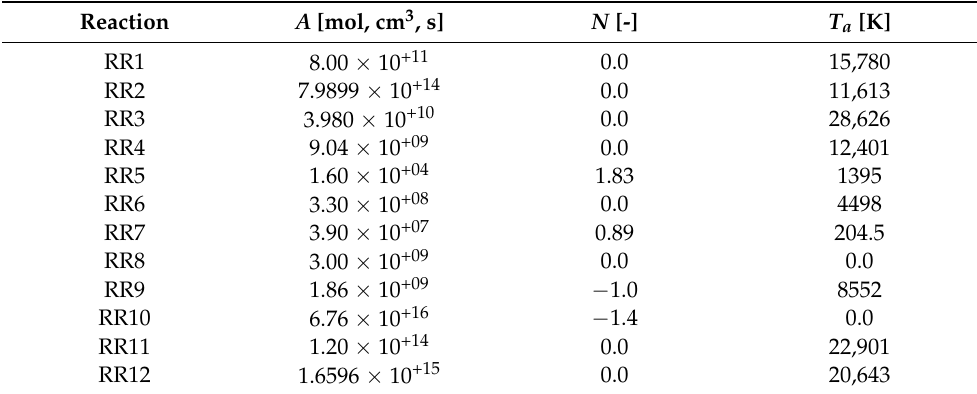
Table 5. Values of A , n and Ta